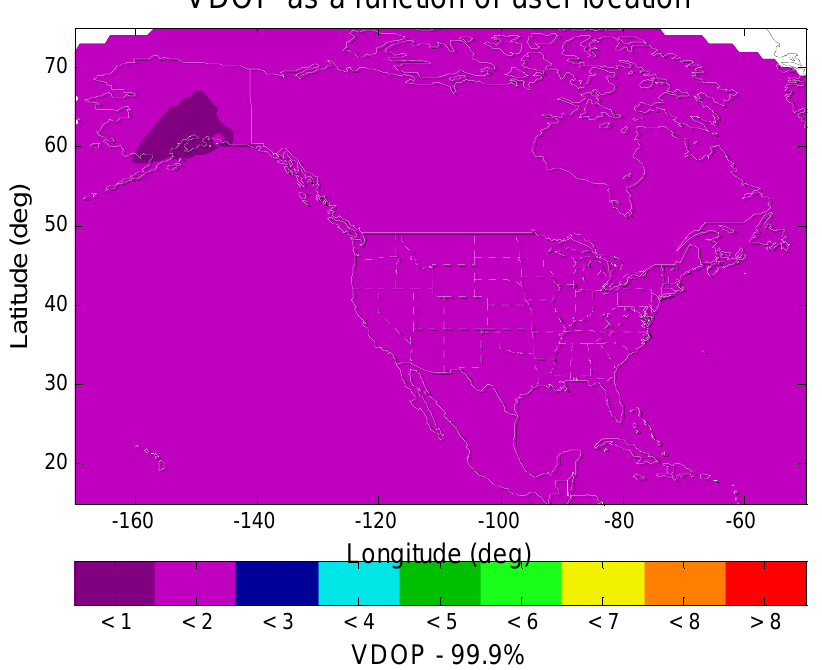
Figure 10. The 99.9% VDOP contour for WAAS with GPS and Galileo. The VDOP values are from 1-2 in all of CONUS, and in all of